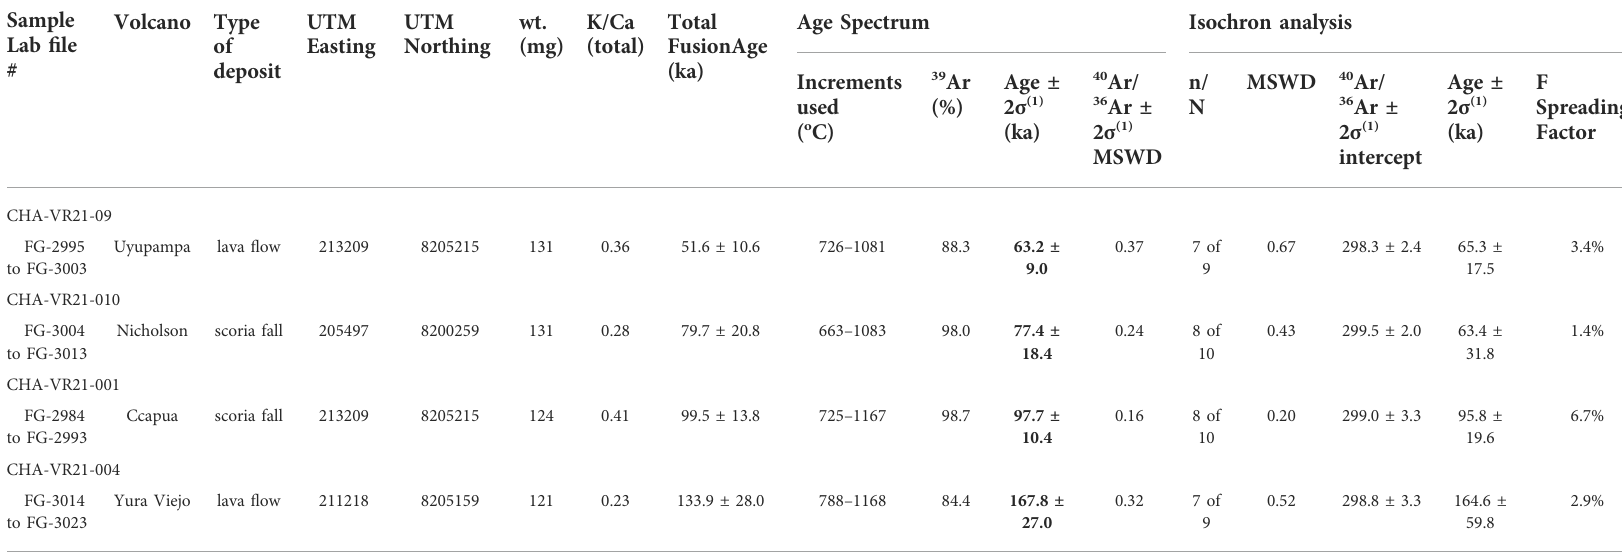
TABLE 4 Summary of 40 Ar/ 39 Ar data from incremental heating experiments on groundmass